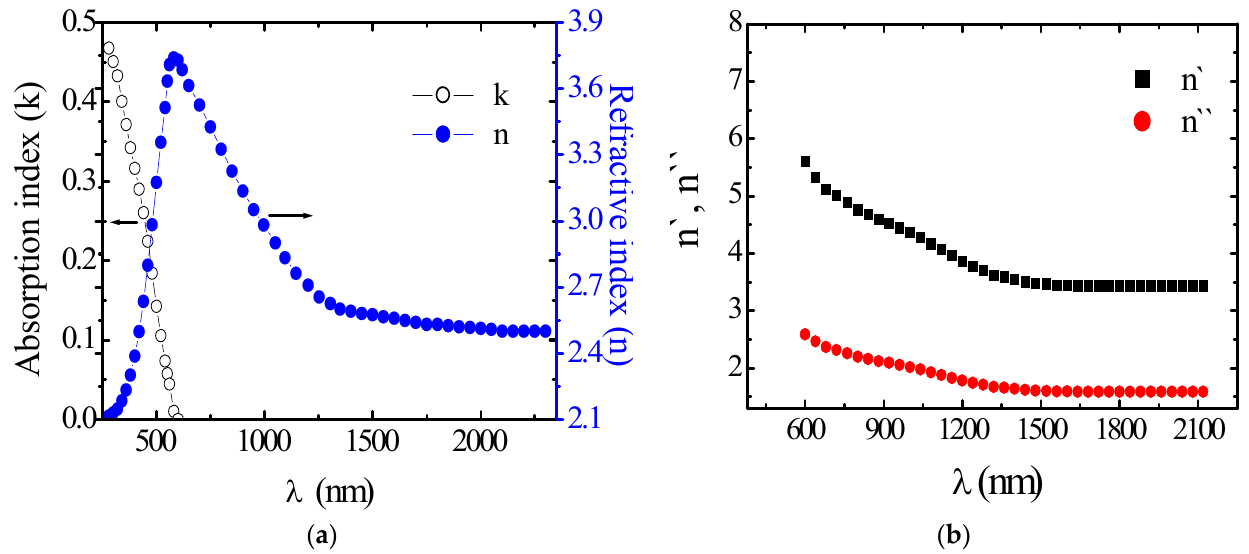
Figure 7. ( a ) Refractive index (n) and absorption index (k) of CdS thin films at different wavelengths. ( b ) The dependence of refractive indices n` and n`` of the wavelength for CdS films.